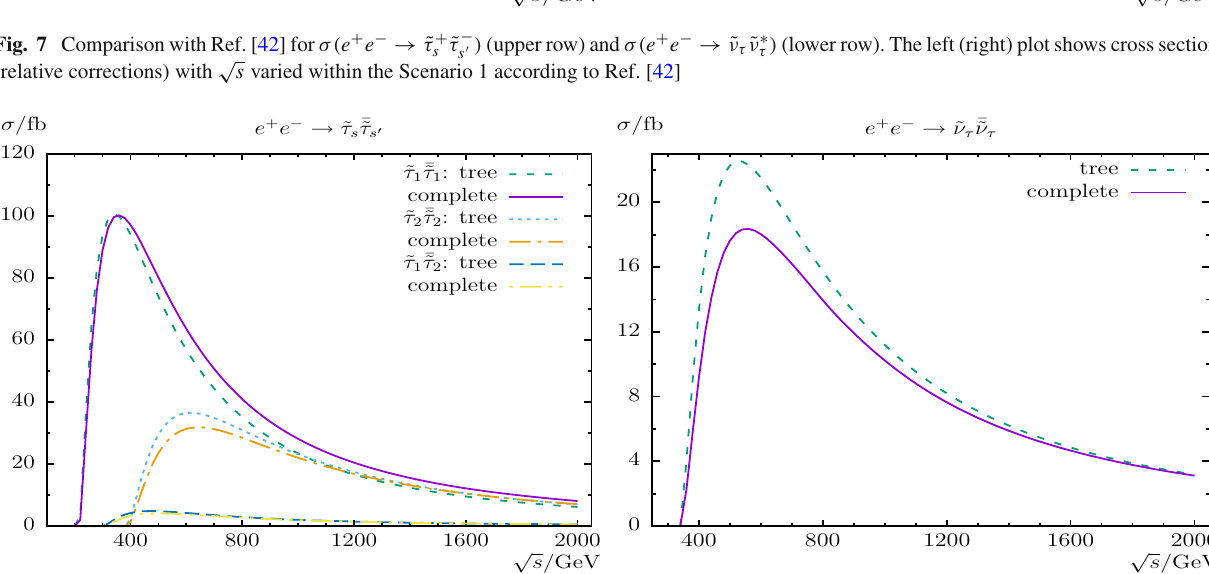
Fig. 8 Comparison with Ref. [44] for σ( e + e − → ˜ τ + s ˜ τ − within the parameter set SPS1 a (cid:3) chosen according to Ref. [44], varied with